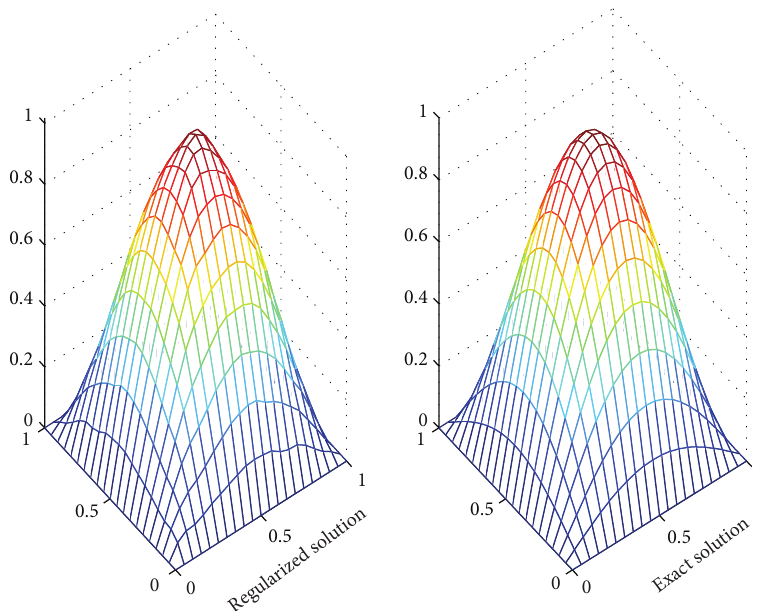
Figure 7: The comparison between the exact solution and regularized solution for Example 3.